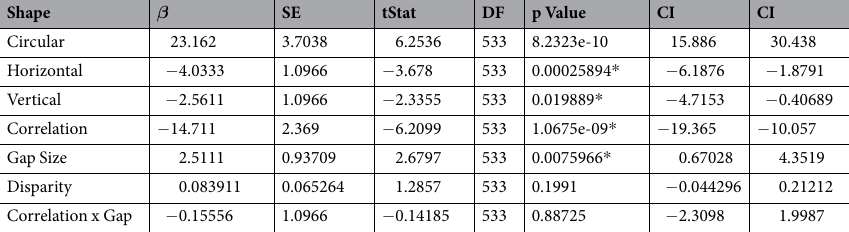
Table 2. Estimates of effects from the linear mixed effects regression for confidence judgements in CRDS and ACRDS stimuli. * Indicates significant p